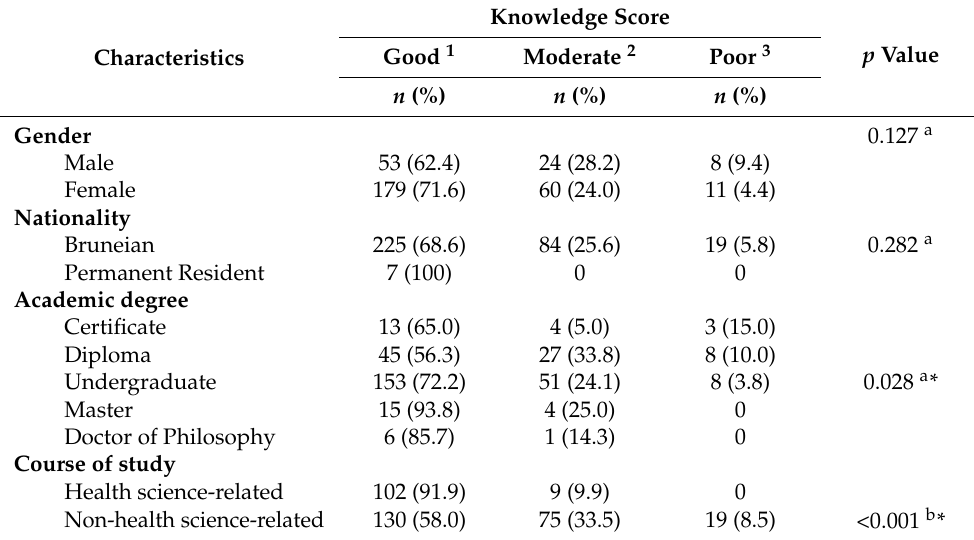
Table 3. Association of demographic characteristics with level of knowledge ( n =